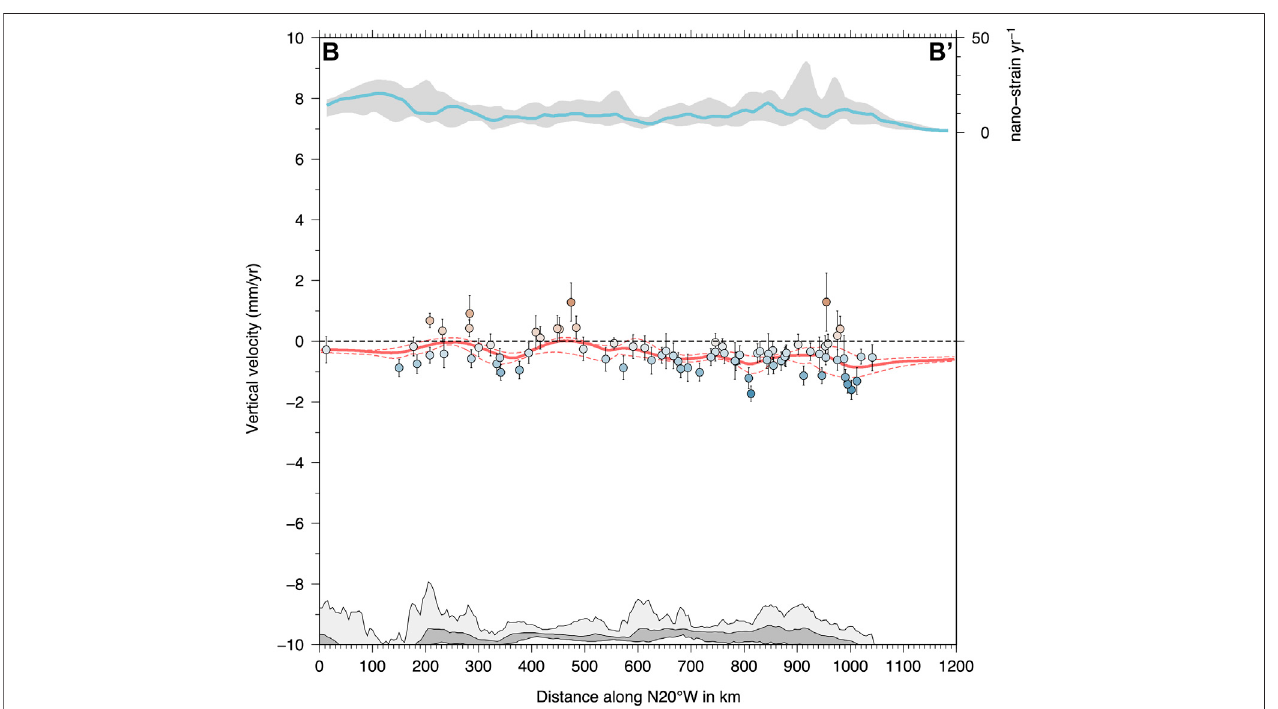
FIGURE12| Verticalvelocitiesalongthepro fi leB-B ’ shownin Figure9 .Coloredcircles(samecolorscaleasin Figure8A )showtheobservedvelocities(witherror bars representing 1 σ uncertainties) of GNSS stations included in a 200 km wide swath pro fi le. The continuous red line in each plot shows the median value of the modeled vertical velocity fi eld obtained using the multiscale approach described in Section 4.2 , where the dashed red lines de fi ne the envelope of the minimum and maximum values of the modeled velocity in the swath pro fi le. The cyan continuous line shows the median value of the scalar strain-rate (see Figure 9 ), where the grayareaistheenvelopeoftheminimumandmaximumvaluesofthestrain-ratevaluesintheswathpro fi les.Atthebottomofthe fi gure,thedarkgray,lightgrayandwhite areas show the average (median), maximum and minimum elevations along the swath pro fi le,